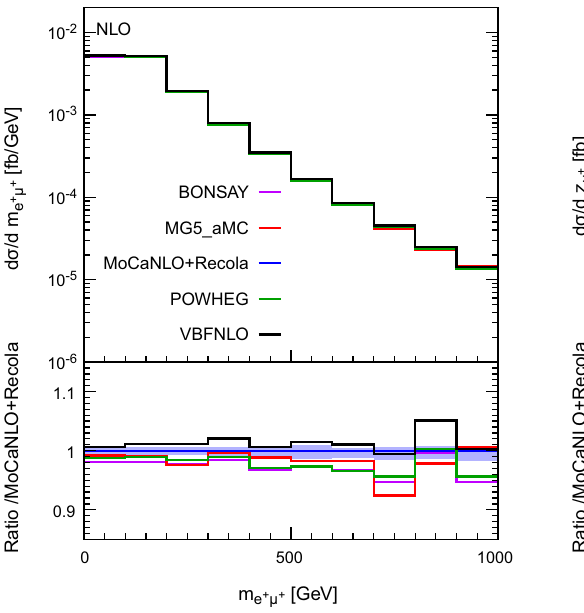
predictions normalised to MoCaNLO + Recola which is the full pre- diction. The band corresponds to a seven-point variation of the renor- malisation and factorisation scales. The predictions are obtained in the fiducial region described in Sect.